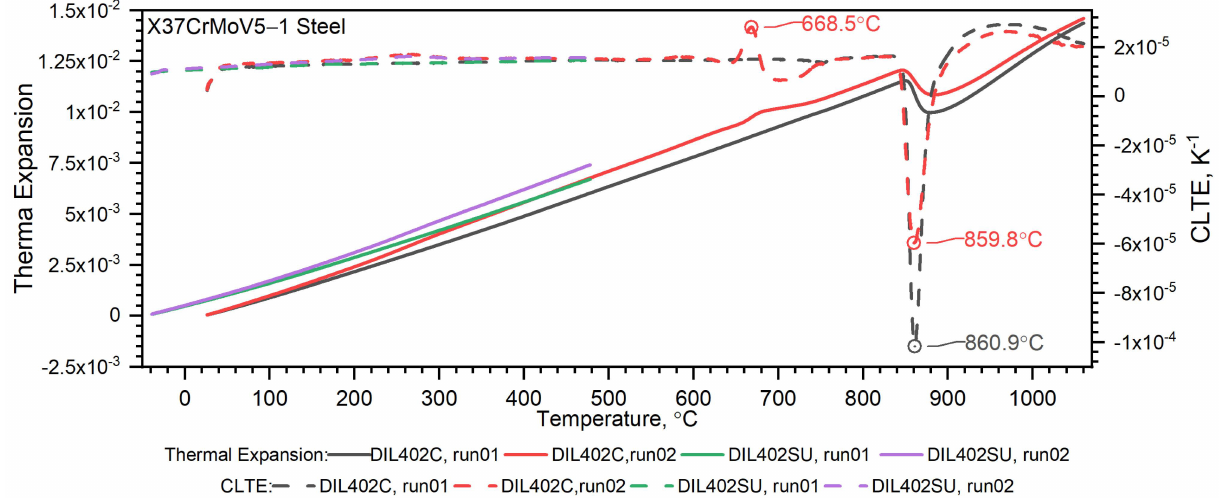
Figure 12. Thermal expansion dL/L o (T) and CLTE as a function of temperature for the X37CrMoV5 − 1 hot-work tool steel obtained from the first and second heating runs on DIL 402 Expedis and DIL 402 C.